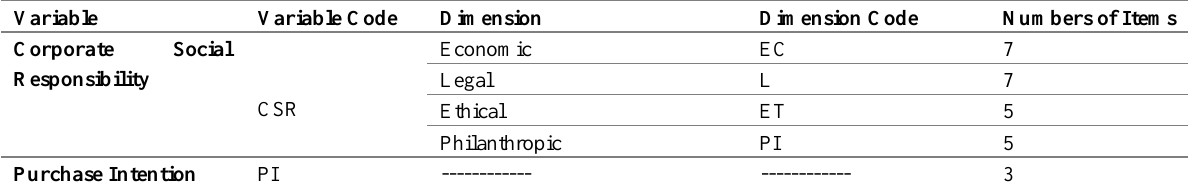
Table 4: Coding of Variables, Dimensions and Items